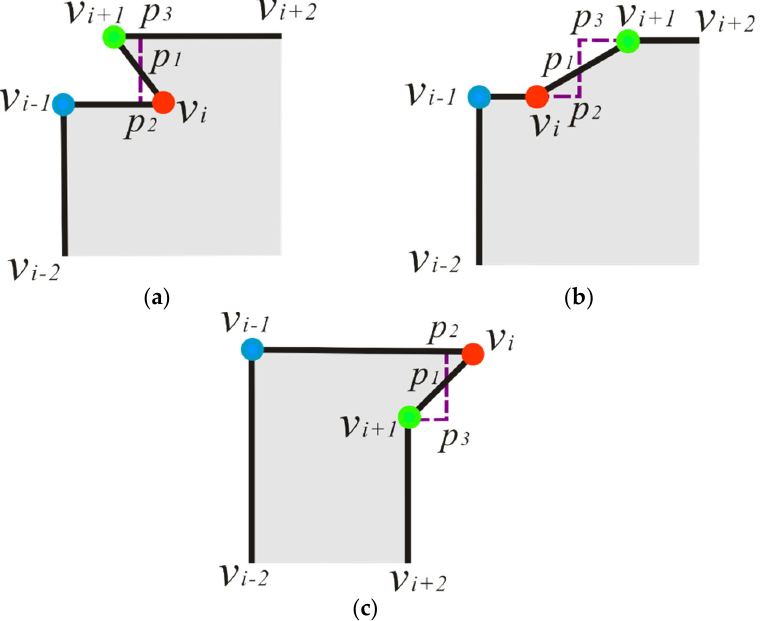
Figure 9. The simplification subtype 10 and its operations: ( a – c ) are different cases of subtype 10.